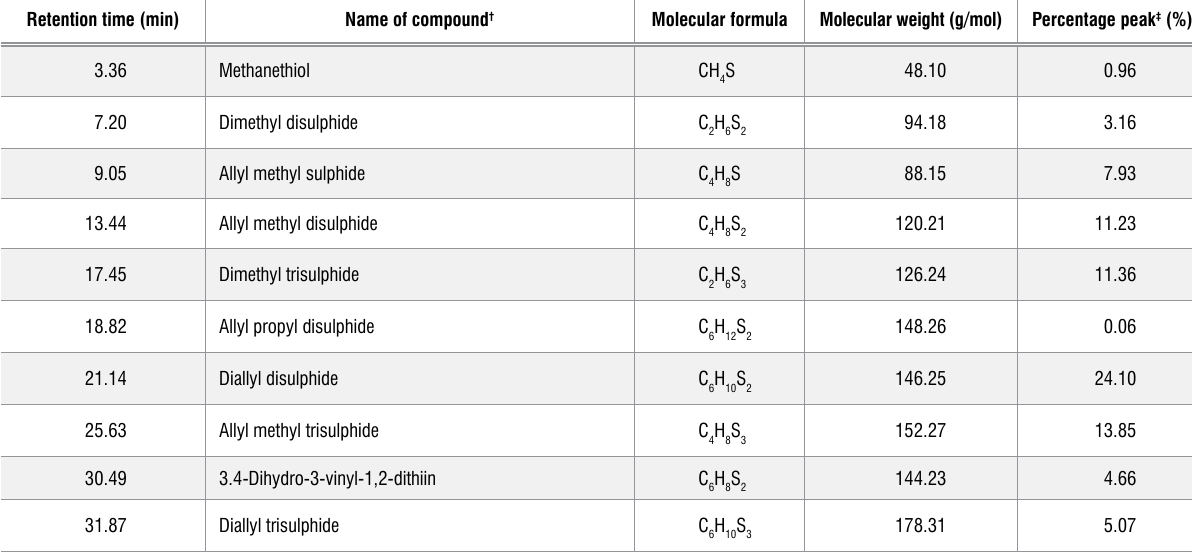
Retention time (min) Name of compound † Molecular formula